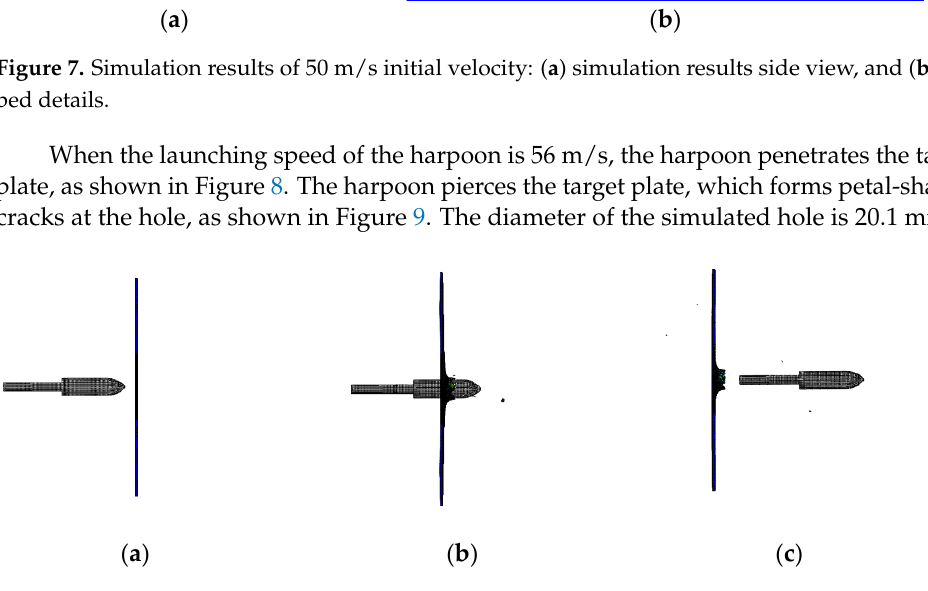
Figure 7. Simulation results of 50 m/s initial velocity: ( a ) simulation results side view, and ( b ) embed details.